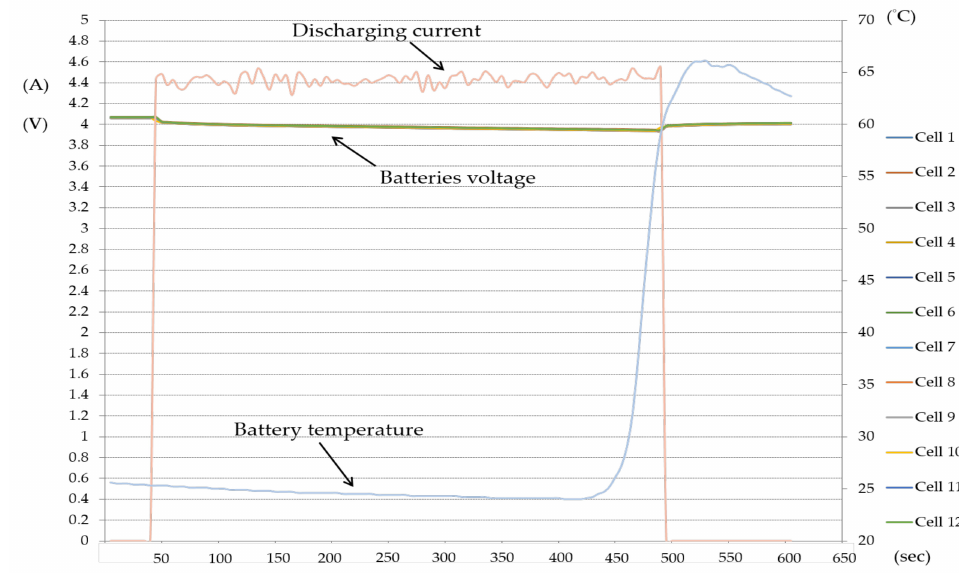
Figure 18. Temperature protection of the lithium-ion battery